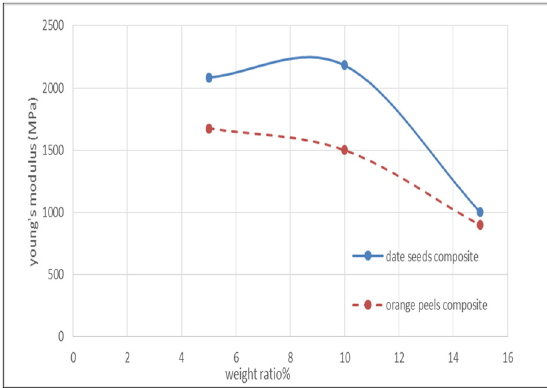
Fig. 5. Effect of weight ratio on Young modulus (natural material).